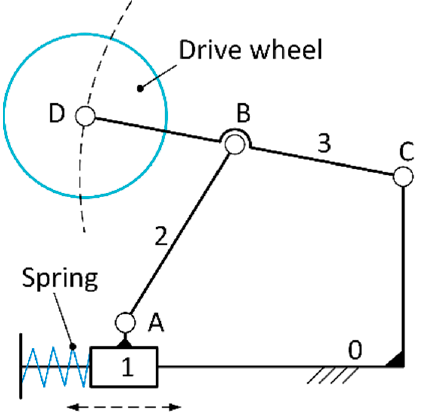
Figure 5. The adapting mechanism for passive module.